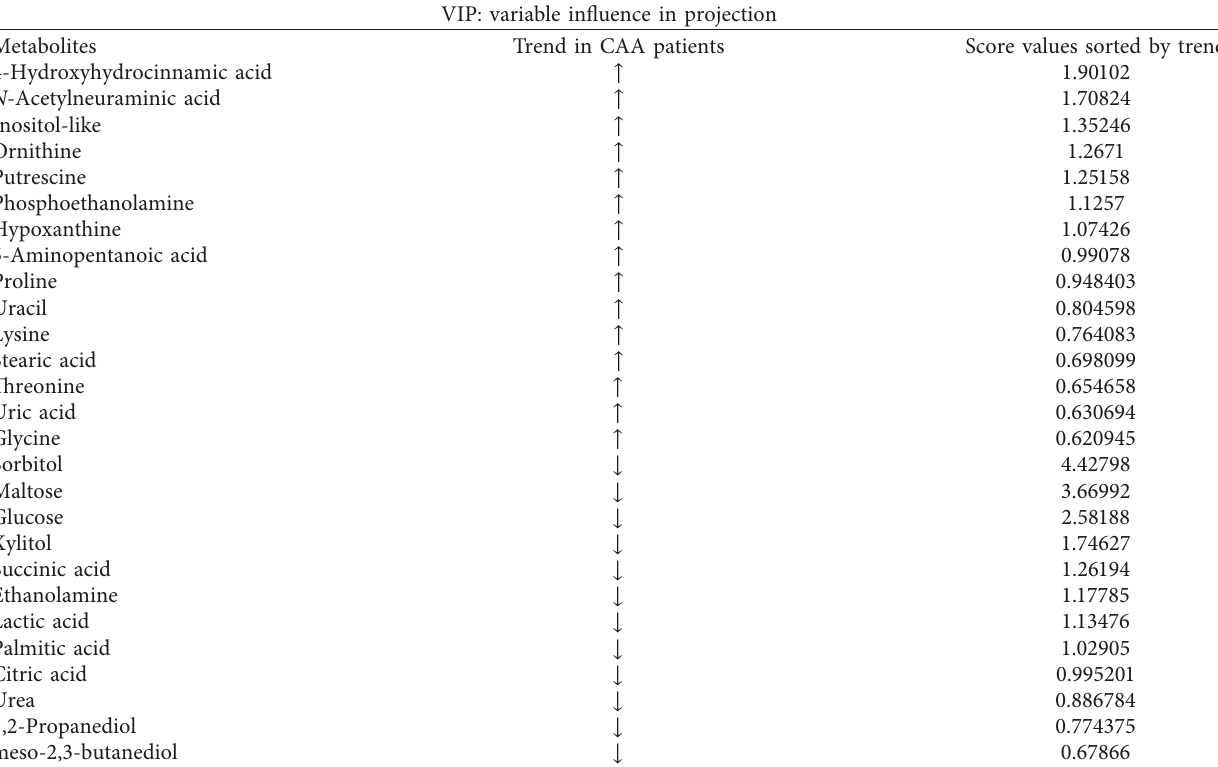
Table 2: Variable influence in projection (metabolites accumulated or depleted in CAA patients sorted by